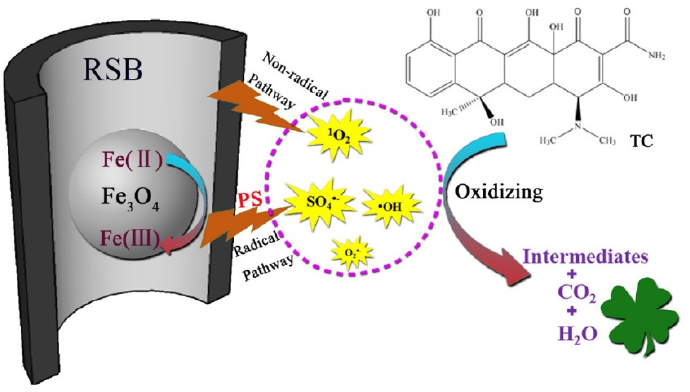
Figure 9. Proposed catalytic mechanism in in the MRSB/PS system [98], Copyright 2021 Elsevier.